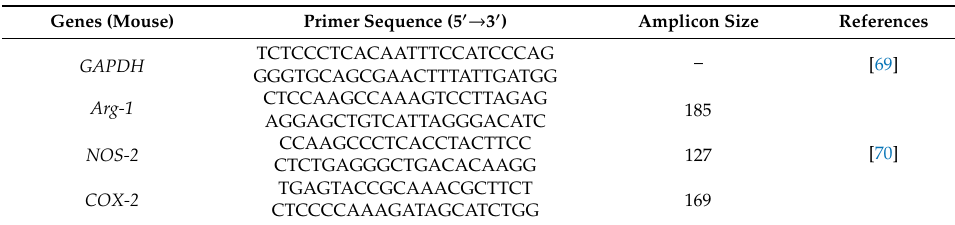
Table 2. Primers used for